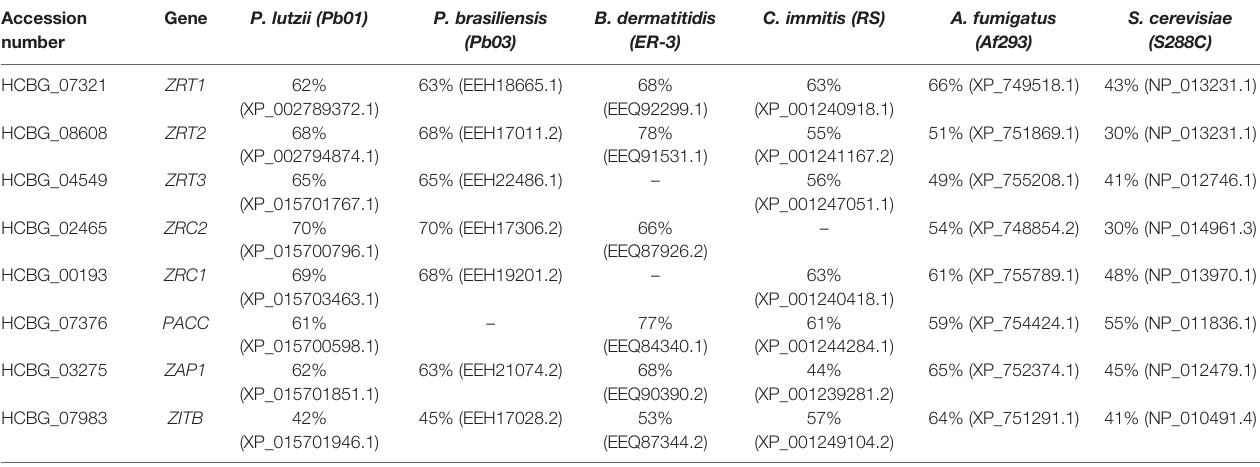
TABLE 1 | Identity of zinc homeostasis related genes of H. capsulatum G186 when compared to functionally characterized